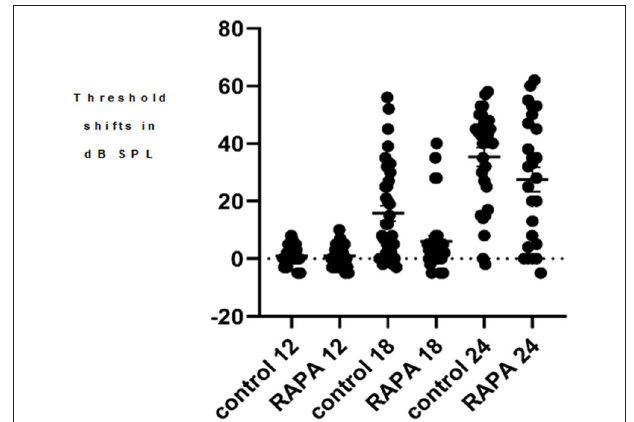
FIGURE 2 | A scatter plot of the 4kHz auditory brain stem response threshold shifts (compared to 5 months of age) at 12, 18, and 24 months of age in the control diet group (without rapamycin) and in the group with rapamycin added to diet at 14 months of age. There is little variability in either group at 12 months of age. At 18 months of age more variability is seen in the control diet group (control 18) while the rapamycin treatment group (RAPA18) remains more skewed toward little threshold shift. At 24 months of age there is less variability in the control group (control 24) now skewed toward large threshold shifts while the rapamycin treatment group (RAPA24) has more distribution across the range of threshold shifts.